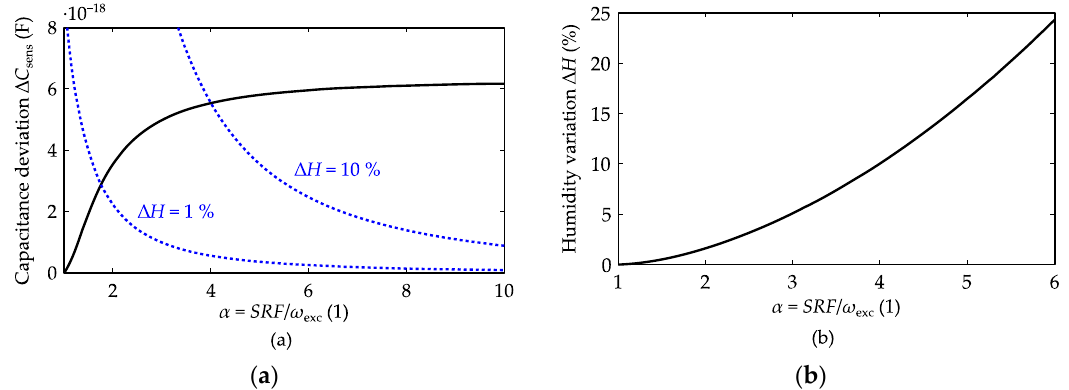
Figure 3. ( a ) Capacitance variation that leads to a 0.1 nm measurement error as a function of the normalized SRF (solid line) and the capacitance deviation resulting from a humidity variation of 1% and 10% (dashed lines); ( b ) Humidity variation as function of the normalized